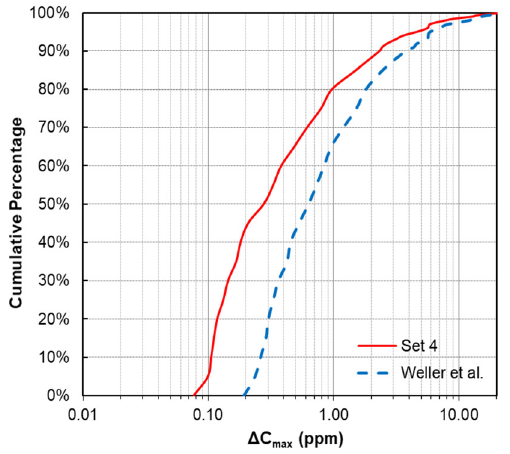
Figure 5. Cumulative percentage plot peak increments contrasting parameter set 4 (280 peaks detected) with parameters representing method of Weller et al. [21] (166 peaks detected).